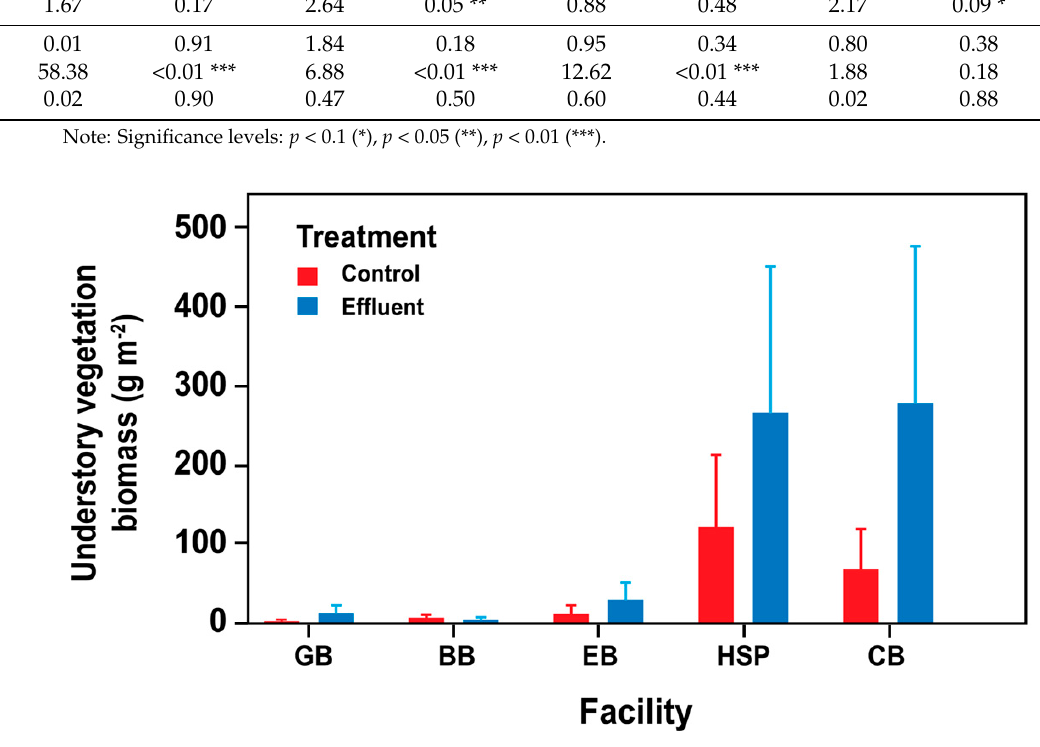
Figure 8. Comparison of understory vegetation biomass at the five reuse facilities. Facility abbrevia- tions are as described in Figure 2. Facilities are arranged in establishment order with GB being first (1978) and CB last